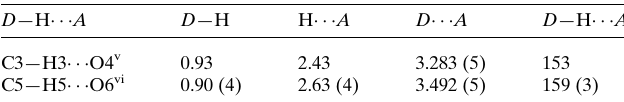
Table 1 Hydrogen-bond geometry (A˚ , (cid:4) ).